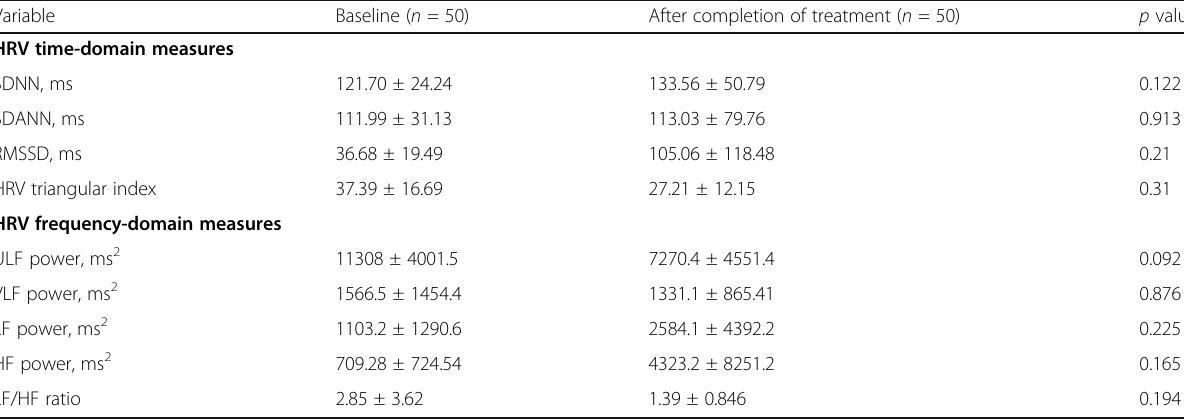
rate, average heart rate), as well as the number of pa- tients with significant pauses, sinus tachycardia episodes, sinus bradycardia episodes, PACs, and PVCs as detailed in Table 1. domain and frequency-domain measures at baseline and after completion of treatment as detailed in Table 2. Table 2 Comparing heart rate variability (HRV) time-domain and frequency-domain measures at baseline and after completion of